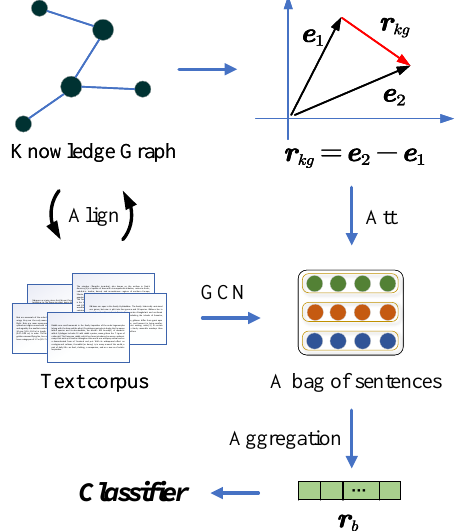
Figure 3. Knowledge attention guided selection of multiple valid